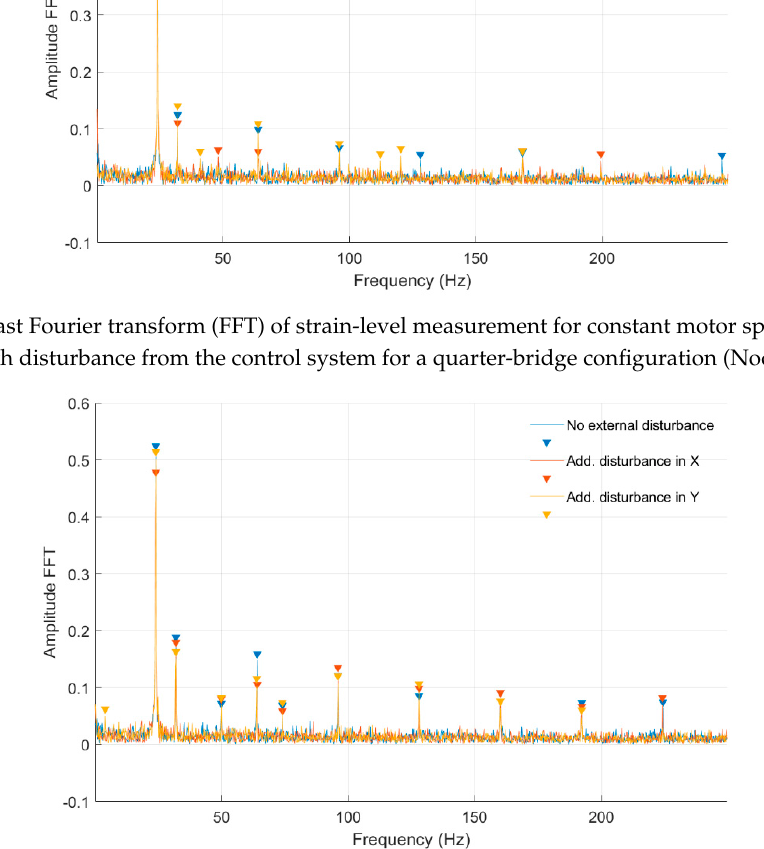
Table 1. List of parameters read from the characteristics shown in Figures 8 and 9.